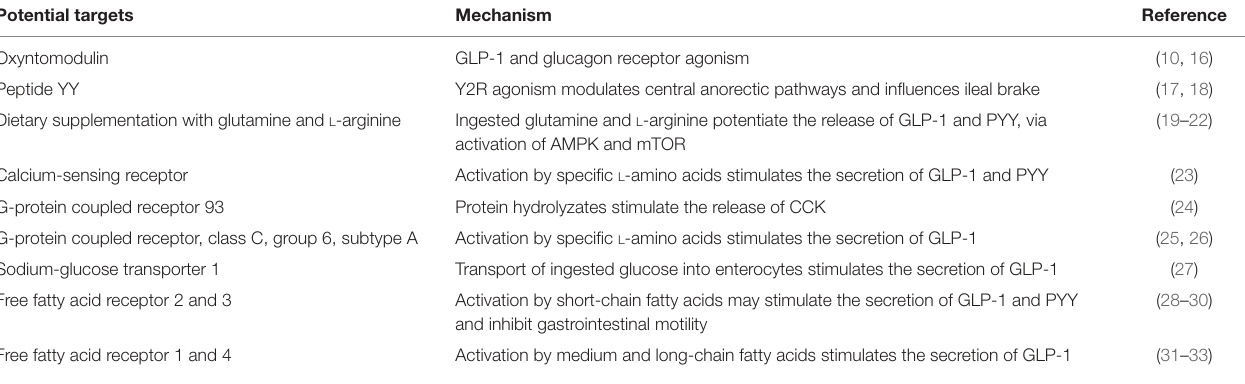
TABLe 1 | A summary of potential targets for the treatment of obesity and their